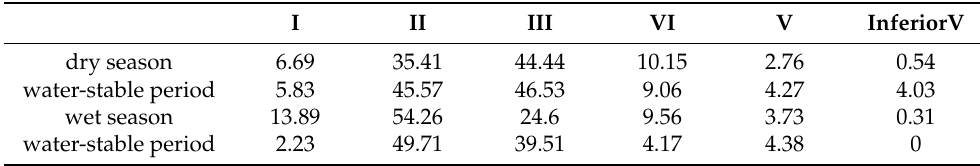
Figure 8. Monthly proportion of different NH 3 -N concentration area. Table 7. NH 3 -N concentration in different water periods.